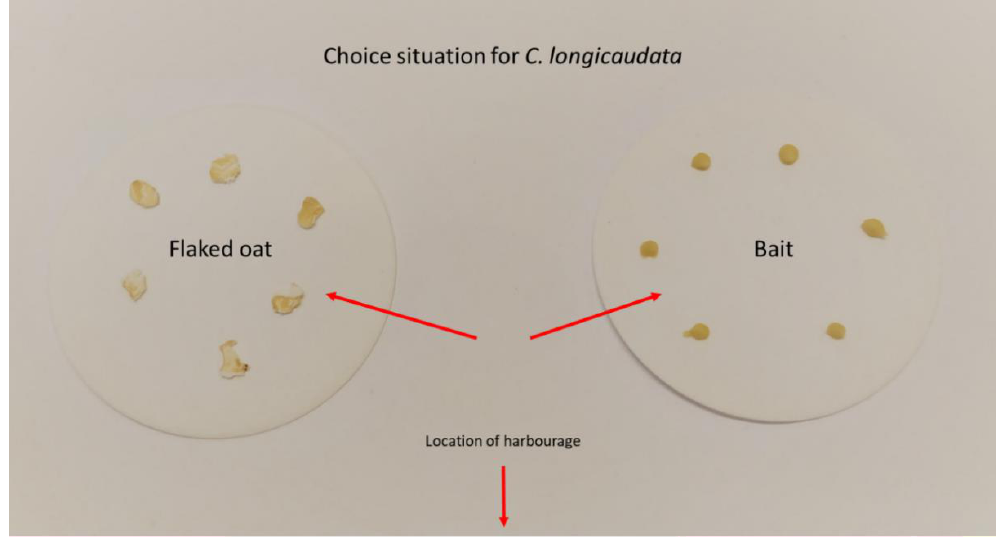
Figure 2. Set-up for choice between food and bait when evaluating commercially available baits against Ctenolepisma longicaudata in arena bioassays.